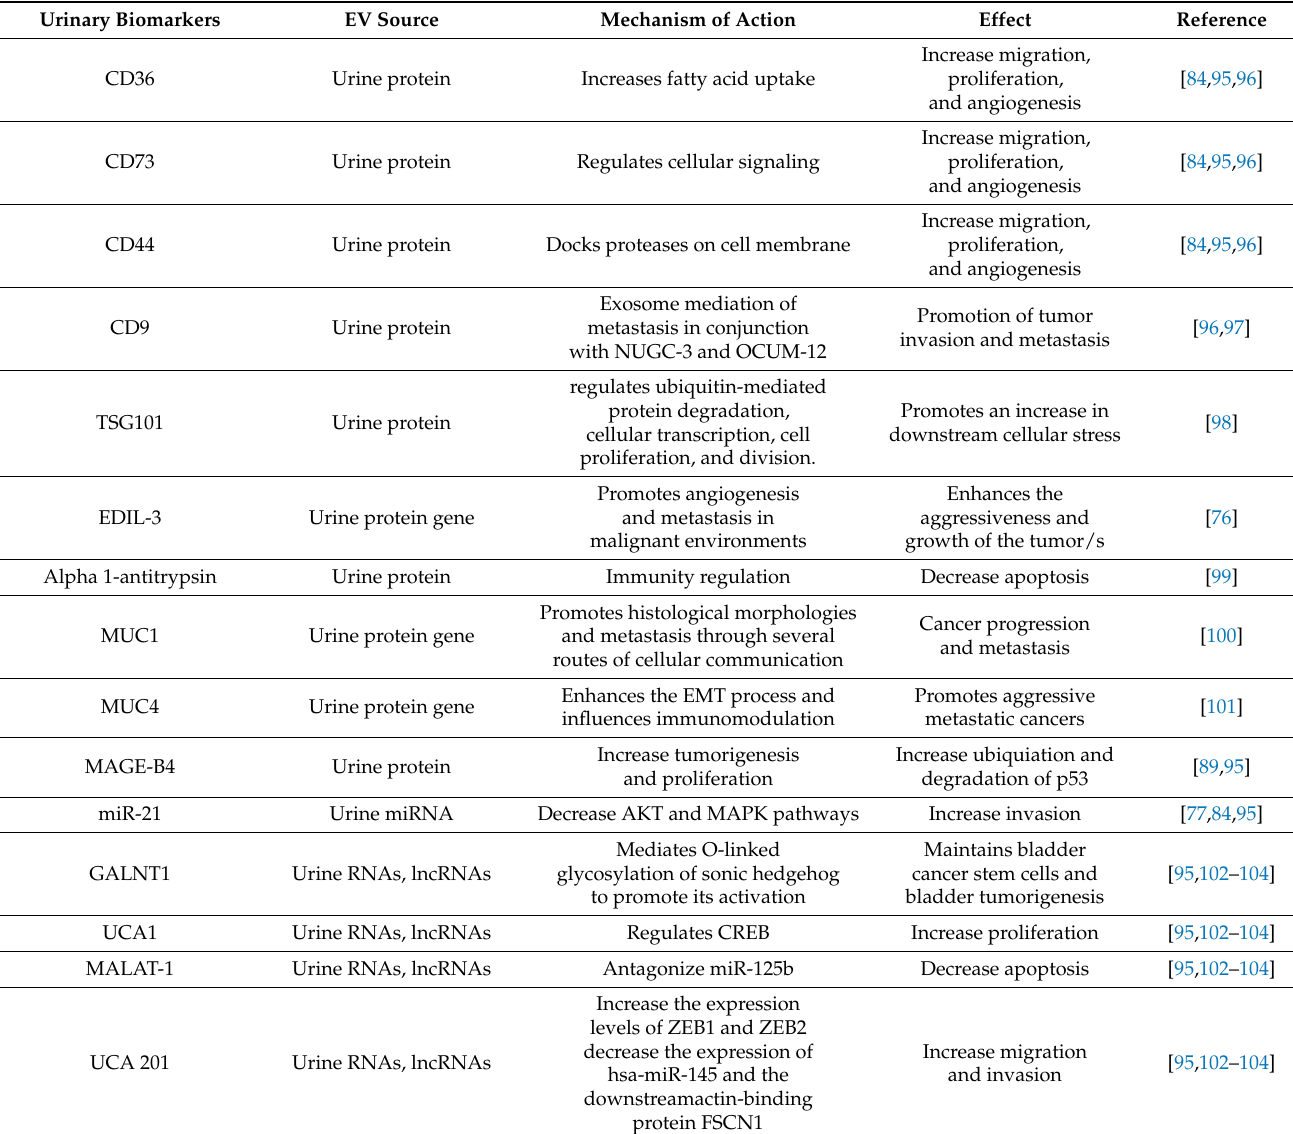
Table 1. Identified Urinary Biomarkers for Bladder